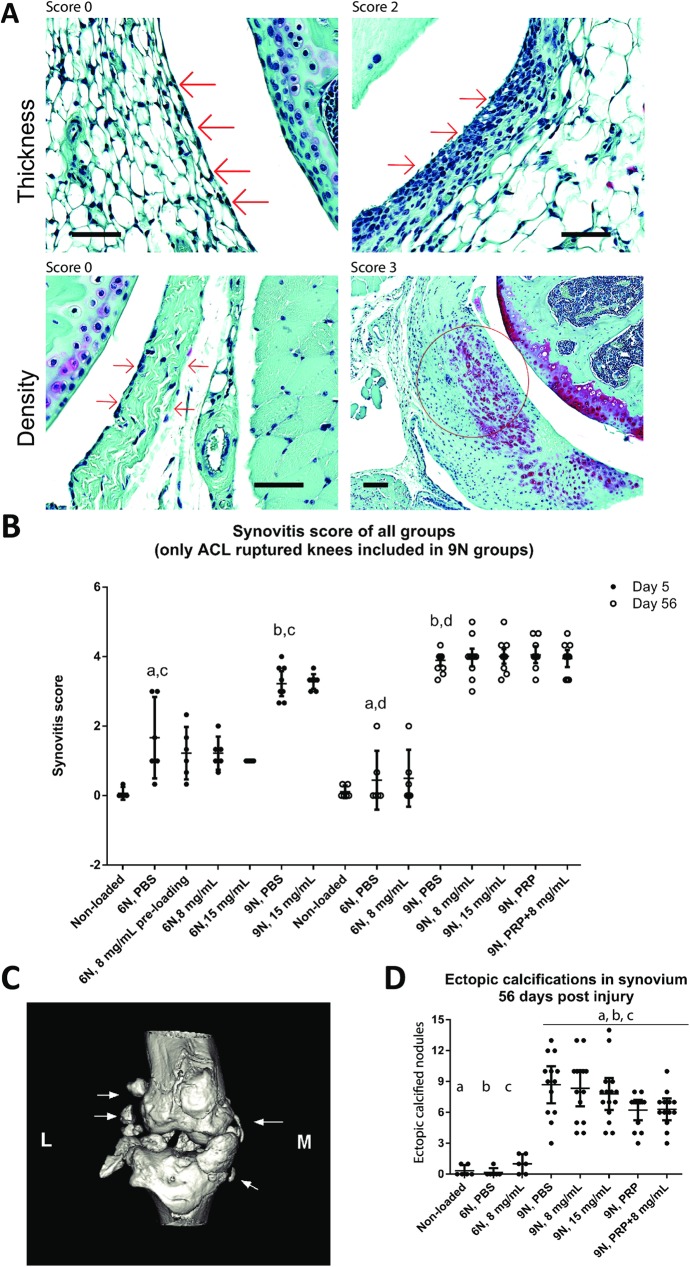
Synovitis and ectopic ossification.Enlargement of the synovial lining cell layer and density of the cells in the synovial stroma (red arrows) were individually assessed. The red circle shows a representative ectopic ossification nodule (A). Quantification of synovitis score in each group indicated that synovitis progressed with time but no significant differences were found in the same loading force groups at the same time point. a, b, c, and d: P < 0.01 (B). A representative micro-CT image showing synovial ectopic calcification is shown in which white arrows show the nodules around the injured knee (C). Quantification of ectopic nodules in each group showed higher number of calcified nodules in the 9N group compared to non-loaded knees and knees loaded with 6N force. There were no significant differences observed within the same loading groups. a, b and c P < 0.01 (D). L = lateral side, M = medial side, bars = 100 μm. Error bars represent 95% confidence interval. PBS = phosphate buffered saline, PRP = platelet-rich plasma.